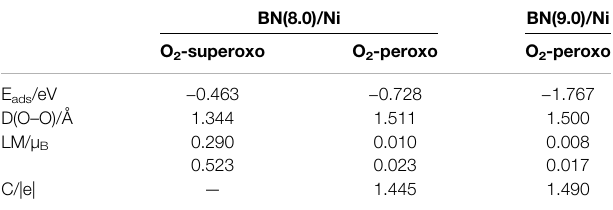
TABLE 1 | The structural, electronic, and magnetic properties of adsorbed O molecules: superoxo chemisorbed, peroxo chemisorbed on BN(8.0)/Ni, and peroxo chemisorbed on BN(9.0)/Ni with the lowest adsorption energy. E ads is the adsorption energy. D(O – O) is the elongated O – O bonds length, LM is the local magnetic moments of two O atoms of the adsorbed O 2 molecule. C is the charge transfer from BN(8.0)/Ni or BN(9.0)/Ni to adsorbed O 2